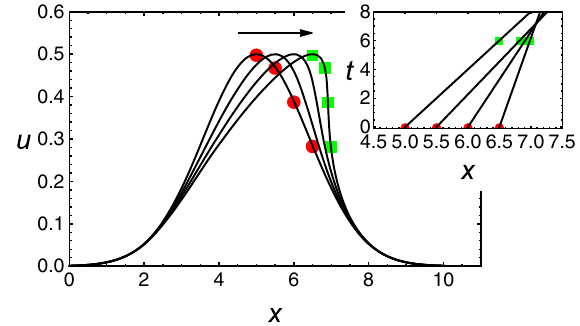
FIG. 2. Time evolution of a generic density profile according to the generalized Burgers ’ equation (1). Curves correspond to profiles at t ¼ 0 , 2, 4, and 6. The (arbitrary) initial profile is taken to be Gaussian, and we adopt f ð u Þ ∝ u 2 . The color dots track constant- u points and show the formation of the universal steep shock-wave profile. Inset: t − x coordinates of the constant- u tracking points (characteristics). The velocity of each point only depends on its u value. The crossing of the characteristics signals the formation of the multivalued steep shock-wave